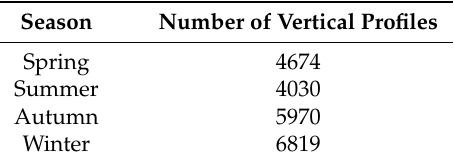
Table A1. The number of AROME-France vertical profiles used in RTTOV